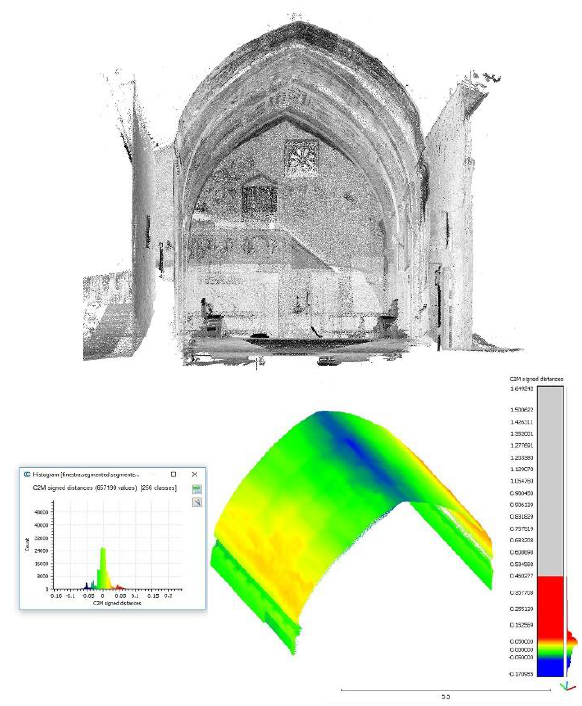
Figure 2: Evaluation of the Level of Accuracy (LoA): deviation between the point cloud and the model of a portion of San Pellegrino church’s vault in Bominaco (L’Aquila) (13th century). on the ability of others to confirm or refute the results obtained”